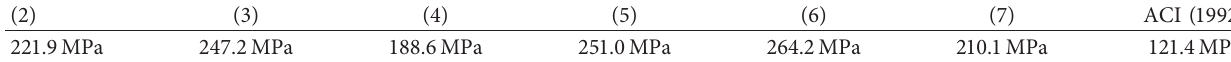
Table 2: The contrast of the S–N curves in differences.